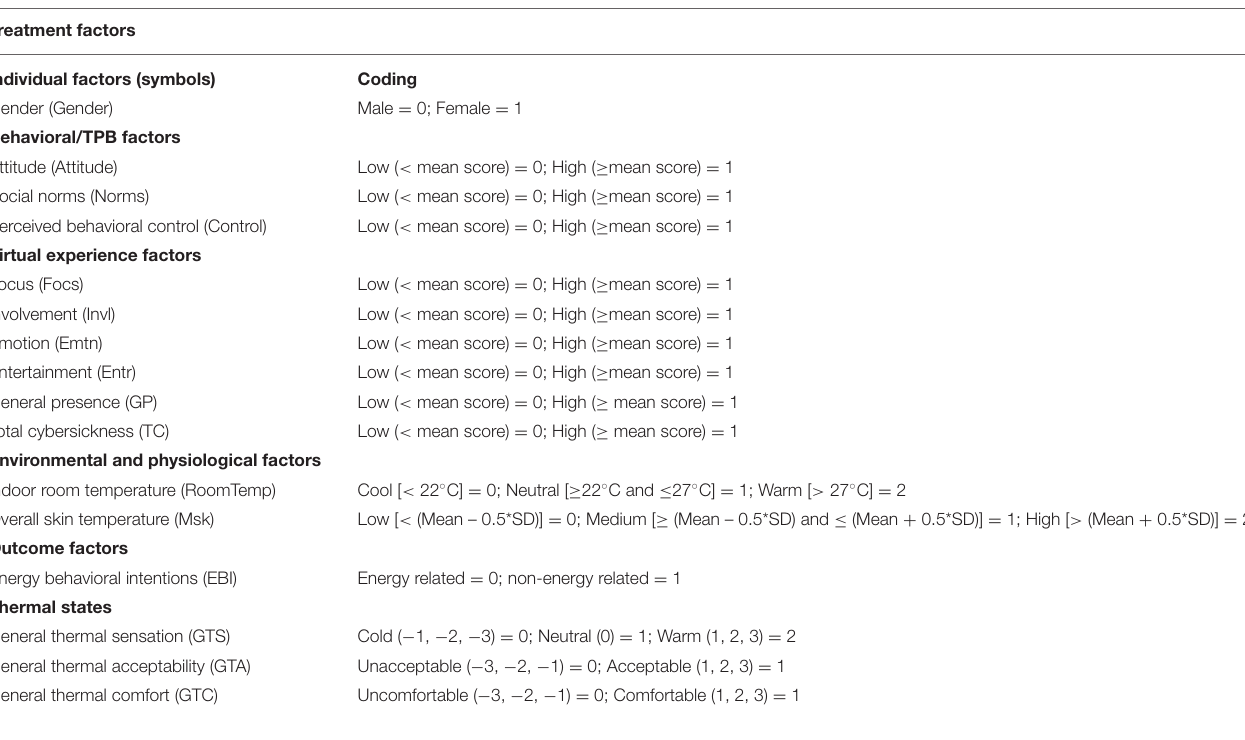
TABLE 2 | Discretization of the treatment and outcome